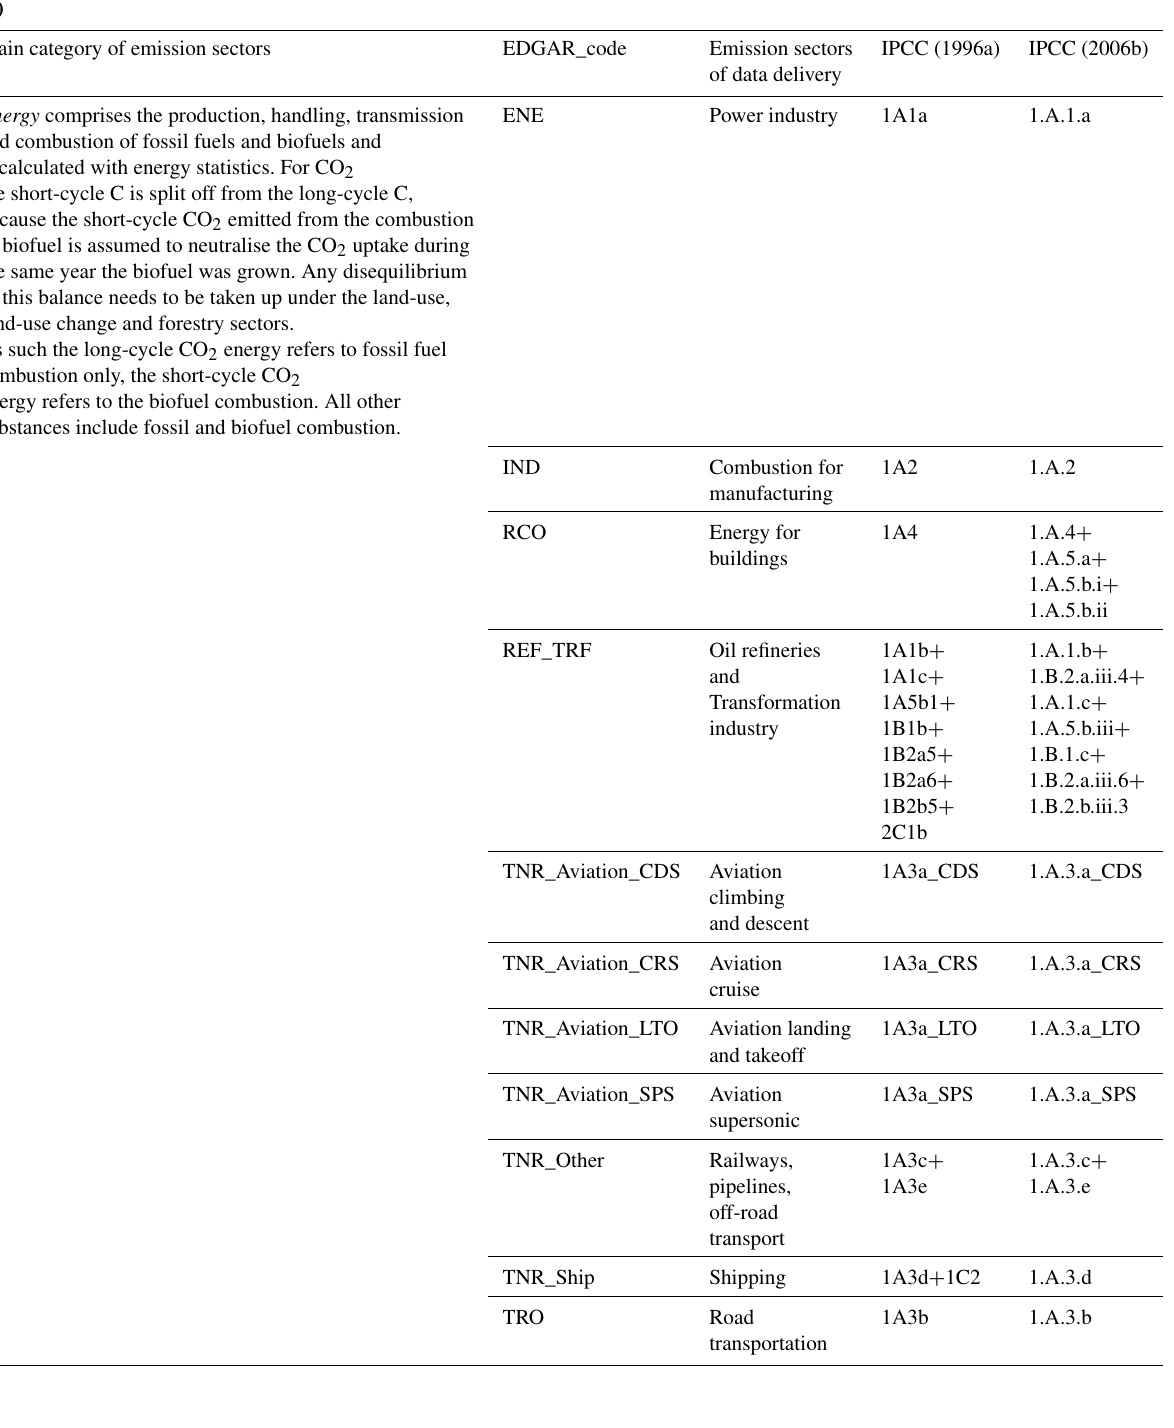
Table 1. (a) Main category with all source/sink categories conforming to the IPCC (1996a, 2006b) Guidelines. Note that neither large- scale biomass burning nor land-use, land-use change and forestry emissions are included, although we do include biofuel combustion and agricultural activities (such as livestock and milk production, crop and rice production, agricultural waste burning, field burning, histosols and liming). (b) Data sources for activity statistics and emission factors for the main categories of emission sources defined in (a) (cf. references in the paper or the